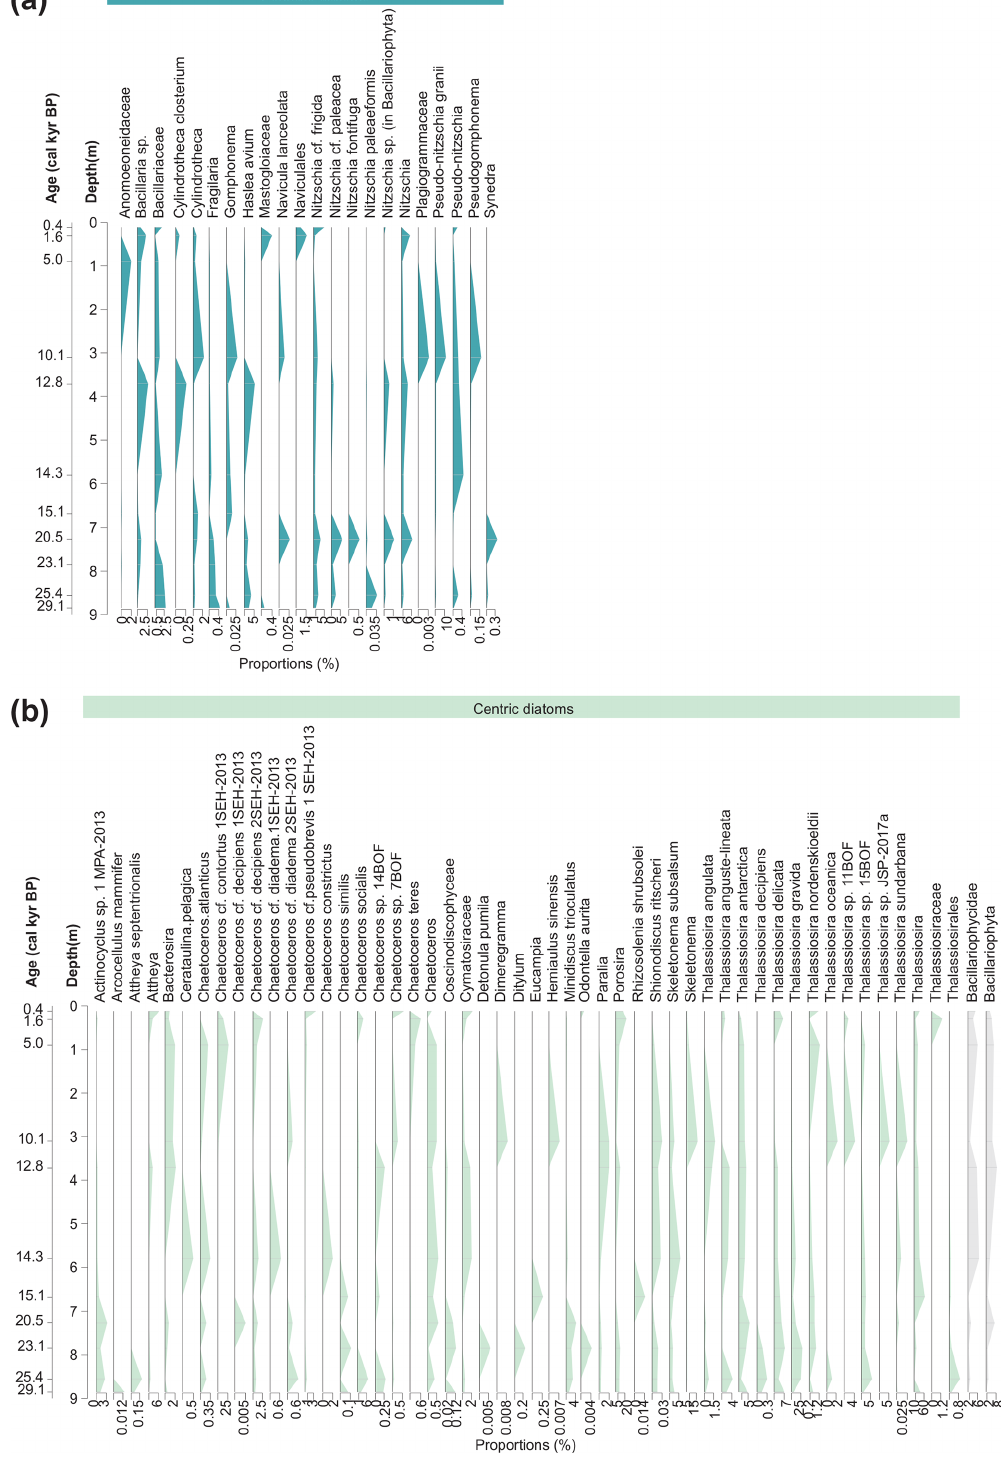
Figure 5. Stratigraphic diagrams with sequences assigned to (a) pennate diatoms (blue) and (b) centric diatoms (green) and higher level sequences assigned between family and phylum level (grey). The taxonomic composition with relative proportions (%) of the 360 detected sequence variants is grouped into 75 unique taxonomic names based on identically assigned taxonomic names of sediment core MSM05/5-